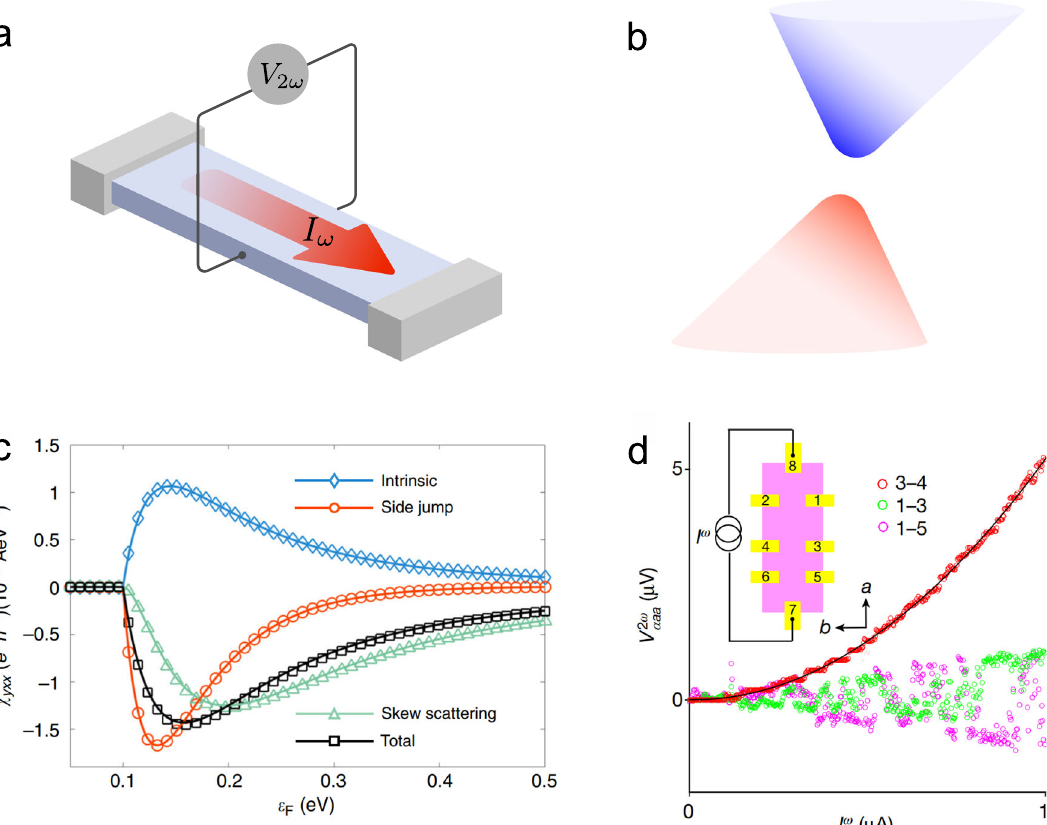
Fig. 2 Nonlinear Hall effect. a Schematic of the measurement setup of the nonlinear Hall effect. b Energy dispersion of a tilted massive 2D Dirac cone, which is the minimal model that supports the nonlinear Hall effect; the blue and red shades represent the Berry curvature with opposite signs. c Different components of the nonlinear Hall conductivity χ yxx , including the intrinsic, side-jump, and skew-scattering contributions, calculated by the Boltzmann equation. Adapted from Ref. 53 . d The measured nonlinear voltages V α aa along the longitudinal (1-3 and 1-5) and transverse (3-4) directions. The inset is the Hall bar device. Adapted from Ref. 60